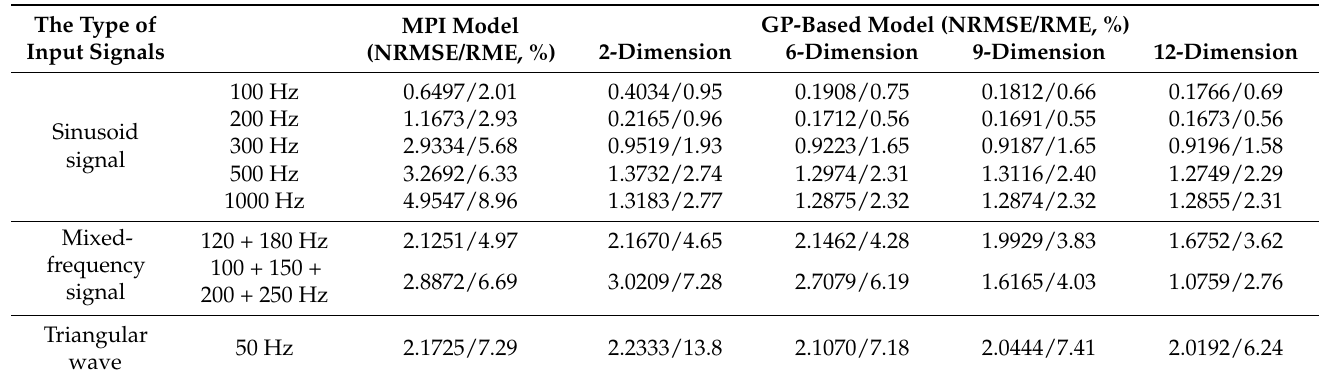
Table 1. Experimental results for the MPI model and GP-based models with different dimensions.